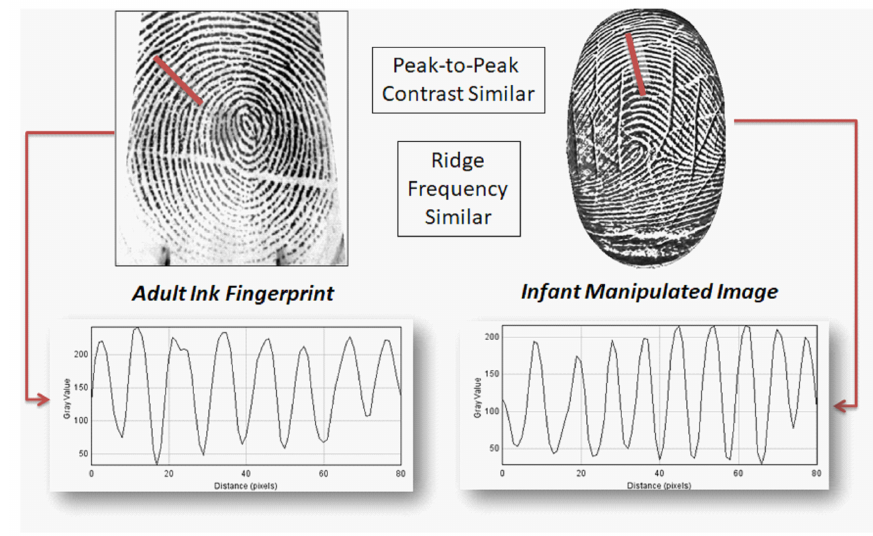
Figure 17. Appropriately acquired and processed infant fingerprints have similar characteristics to adult